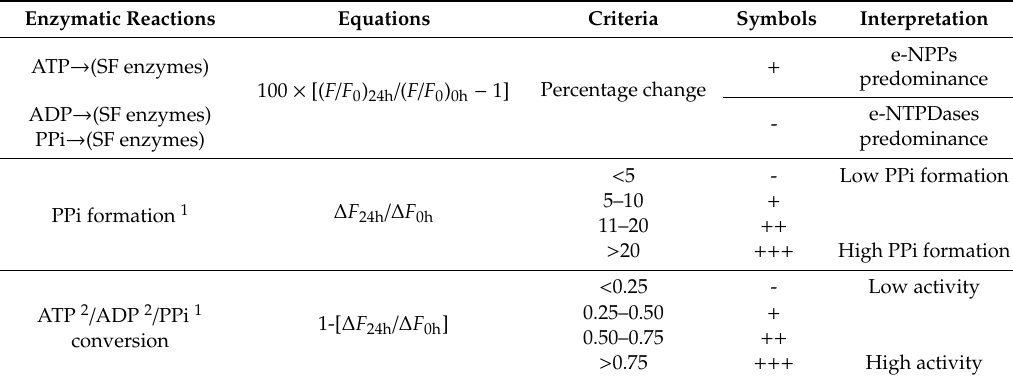
Table 2. Equations and criteria used for calculation of SF enzymatic activities.